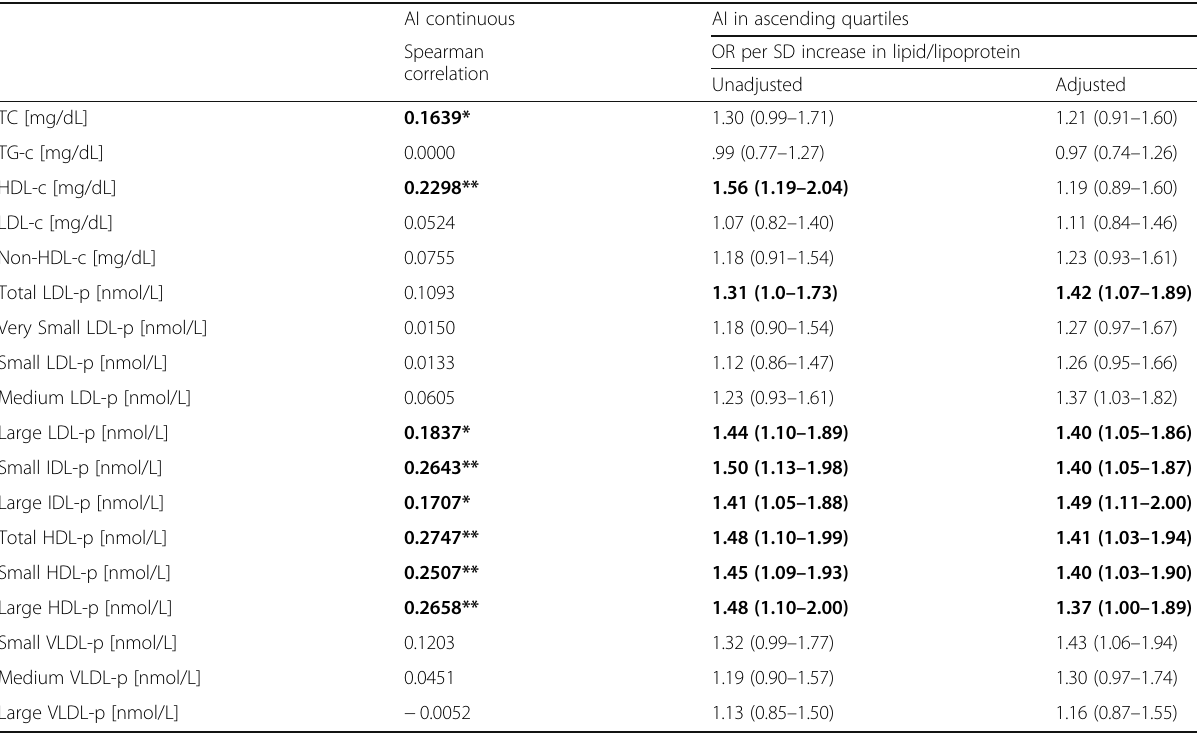
Table 2 Association of lipoprotein (LP) subclasses with augmentation index (Al) quartiles in study population (expressed as